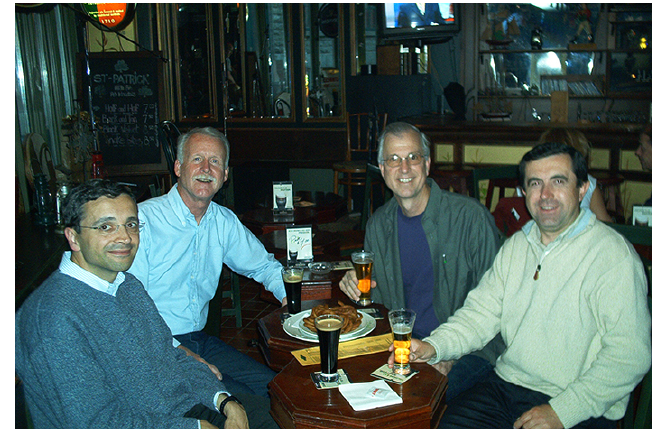
Figure 5: From left to right: José Antonio Rodríguez Lallena, Roger Nelsen, Greg Fredricks, José Juan Quesada Molina in 2004 during the DeMoSTAFI conference held in Québec from 20-22